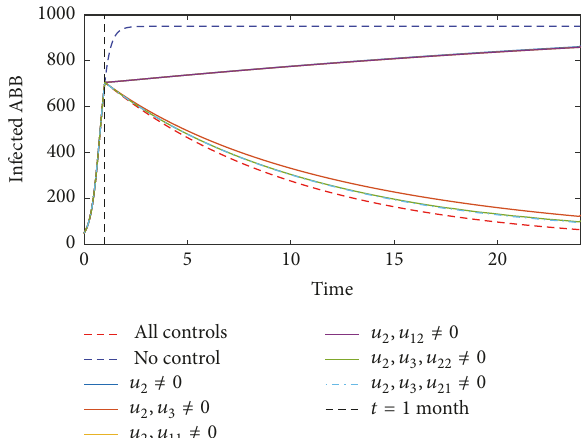
Figure 2: Simulation for the number of infected stems for ABB- genome comparing different control strategies after time 𝑡 = 1 monthappliedforaperiodof24months:(A) (𝑢 2 ̸= 0) ,(B1)( 𝑢 2 ,𝑢 12 ̸= 0 ), (B2) ( 𝑢 ,𝑢 ̸= 0 ), (B3) ( 𝑢 ,𝑢 ̸= 0 ), (C1) ( 𝑢 , 𝑢 ,𝑢 ̸= 0 ), (C2) 2 11 2 3 2 3 21 ( 𝑢 2 ,𝑢 3 ,𝑢 22 ̸= 0 ), and (D) (all controls). Parameters are as given